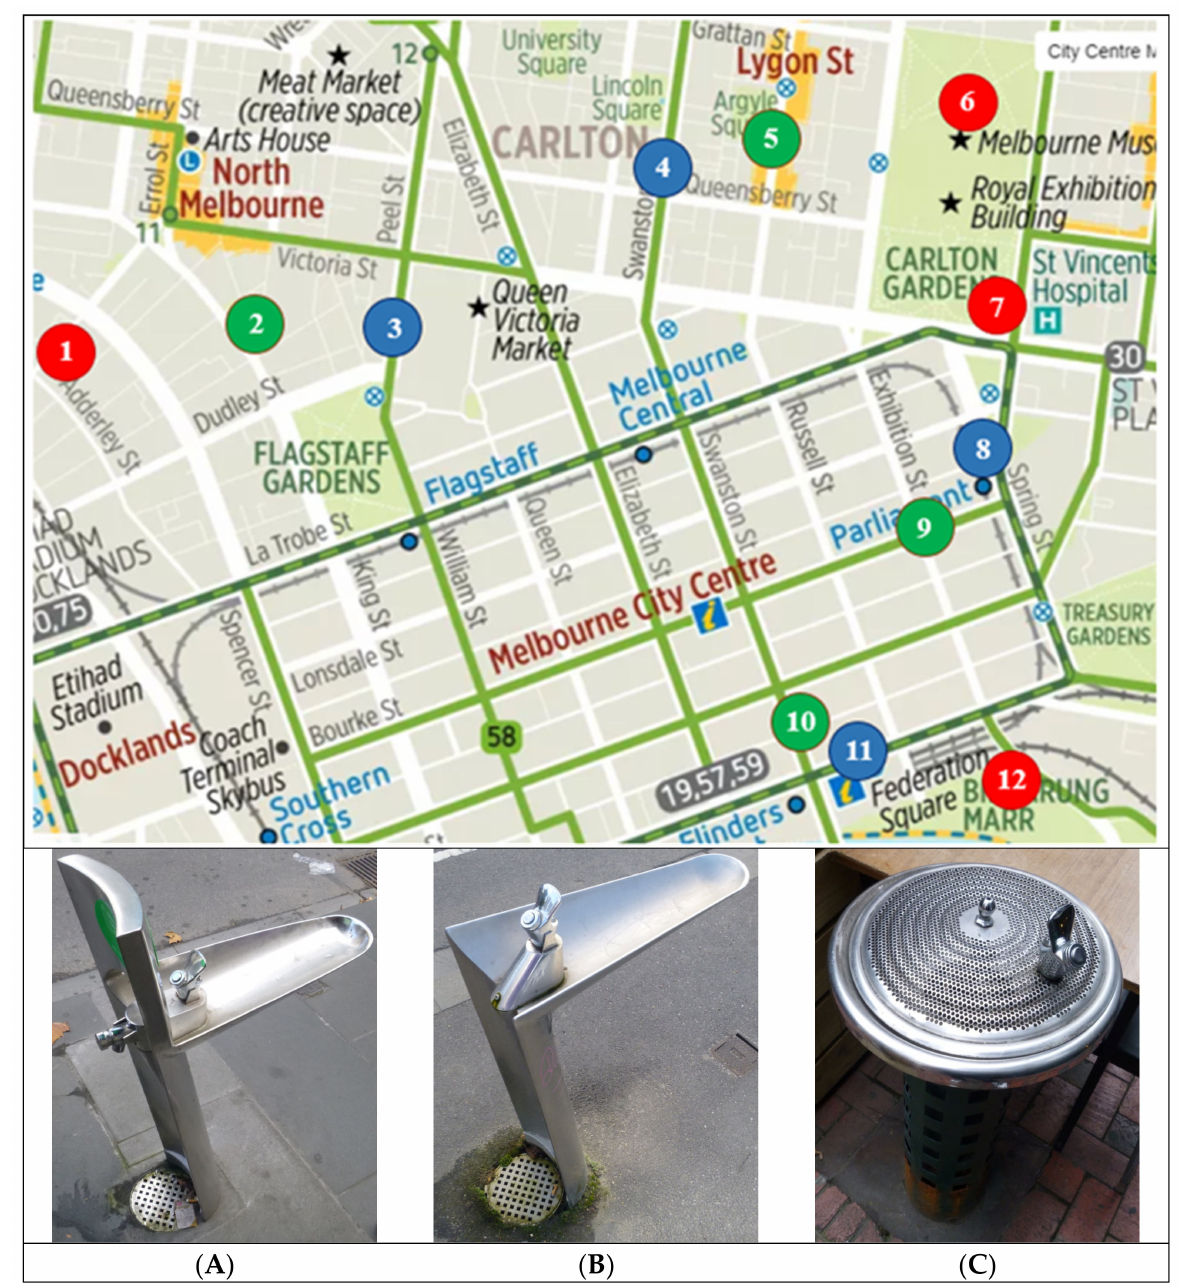
Figure 1. Map showing the location of the 12 sampling points and fountain types ( A ) ( ), ( B ) ( ) and ( C ) ( ) [40] and images of the three fountain types ( A ), ( B ) and ( C )